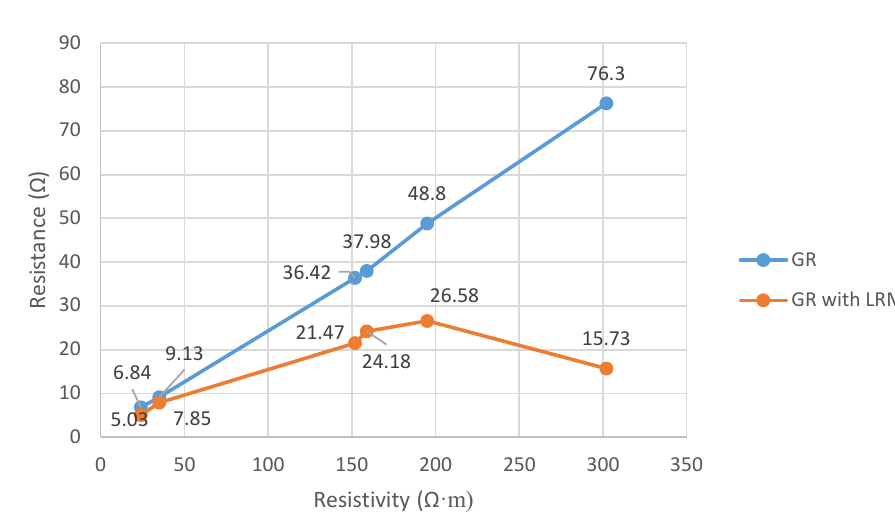
Figure 8. GR vs. 1R resistivity.